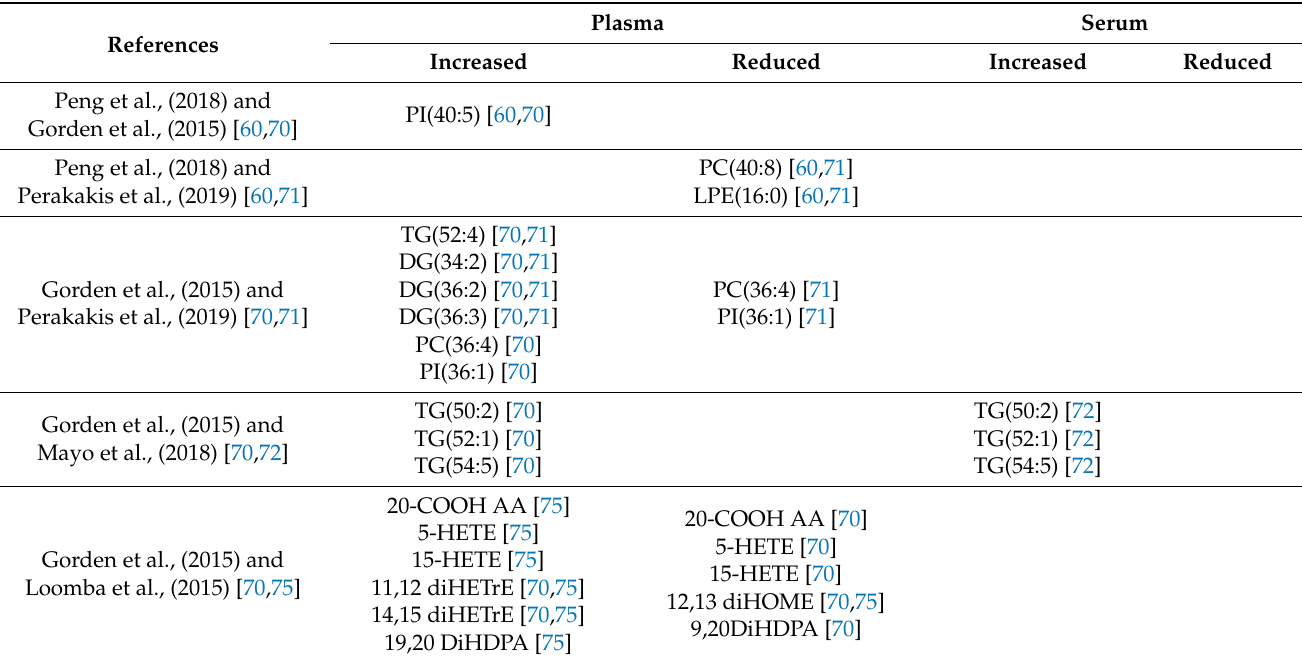
Table 1. Results from published studies on circulatory lipids in patients with